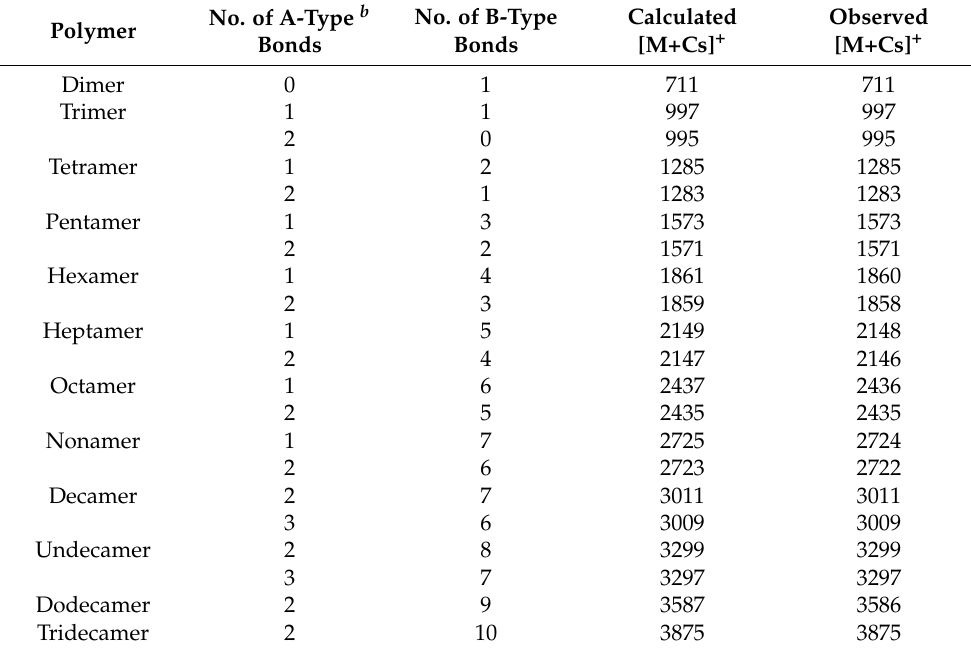
Table 1. Observed and calculated masses a of heteropolyflavan-3-ols by MALDI-TOF/MS. Polymer